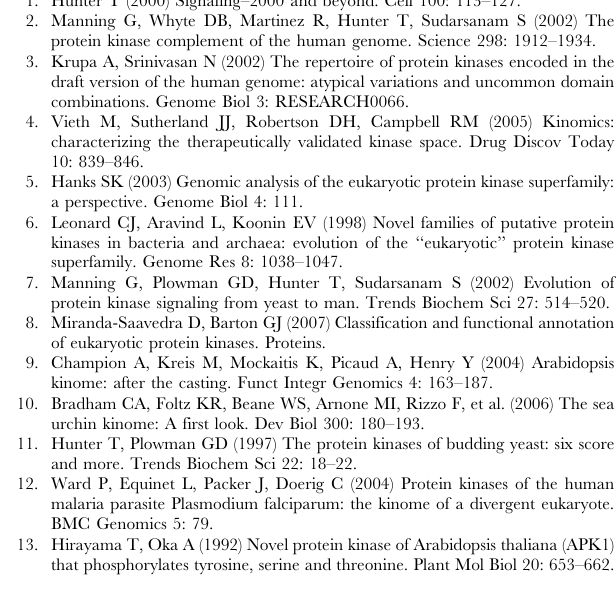
XLS) Table S5 Presence (1) or absence (0) of spots phosphorylated averaged for the different organisms. Found at: doi:10.1371/journal.pone.0000777.s005 (0.25 MB XLS) Table S6 Calculation of the probability that 116 trials (substrates) are positive (in at least 90% of the samples, corrected for origin bias) in a total number of 1152 trials (= whole PepChip) using a binominal distribution calculation (http://www.stat.sc. edu/ , west/applets/binomialdemo.html). The p-value for success in the binomial distribution is calculated by using the cumulative relative amount of positive spots for every organism. The result of this test shows the chance that a spot is phosphorylated in every set. Found at: doi:10.1371/journal.pone.0000777.s006 (0.32 MB XLS) Histogram S1 Histogram of frequency distribution of Table S3. Found at: doi:10.1371/journal.pone.0000777.s007 (0.02 MB XLS) Histogram S2 Histogram of frequency distribution of Table S4. Found at: doi:10.1371/journal.pone.0000777.s008 (0.02 MB XLS) Histogram S3 Histogram of frequency distribution of Table S5. Found at: doi:10.1371/journal.pone.0000777.s009 (0.03 MB